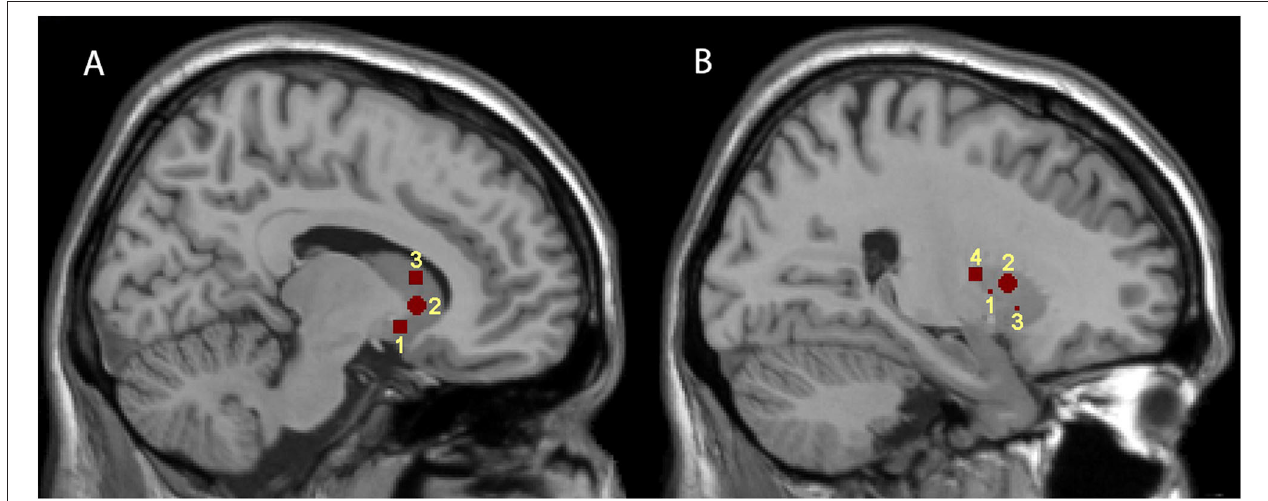
FIGURE 1 | Representations of the seven striatal seed regions. (A,B) are sagittal brain views at x = 9 and 24, respectively. (A) illustrates the positions of the three caudate subdivisions; 1, 2, and 3 represent VSi, VSs, and DC, respectively. (B) illustrates the positions of the four putamen subdivisions; 1, 2, 3, and 4 represent DCP, DRP, VRP, and PCP, respectively.